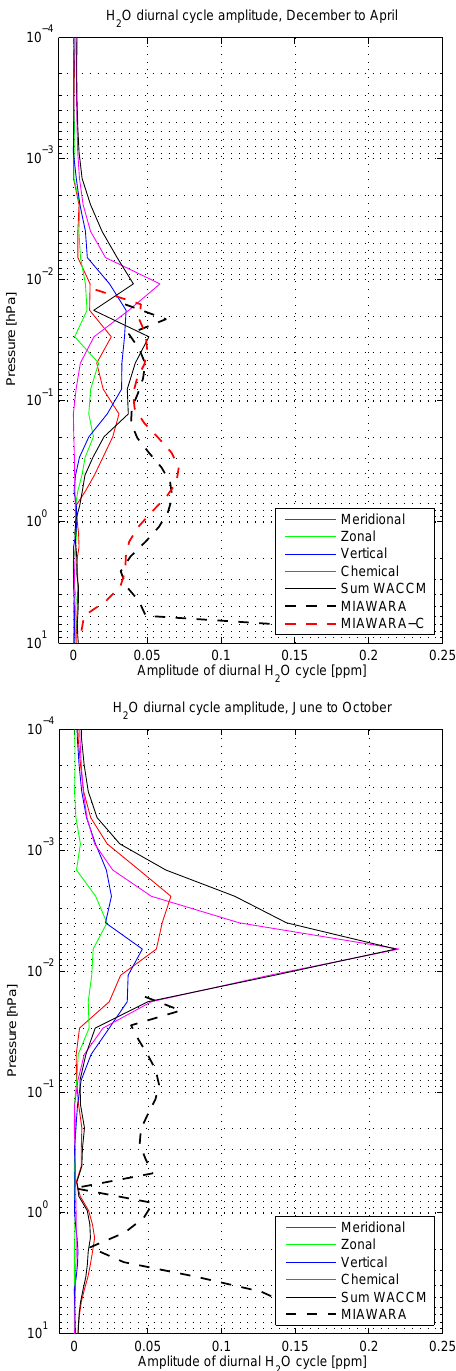
Fig. 5. Amplitudes of the diurnal cycle of water vapor from MI- AWARA, MIAWARA-C and WACCM and due to meridional, zonal and vertical advection and (photo-)chemistry (based on the WACCM data). Upper panel: December to April. Lower panel: June to October. MIAWARA-C was not available from June to